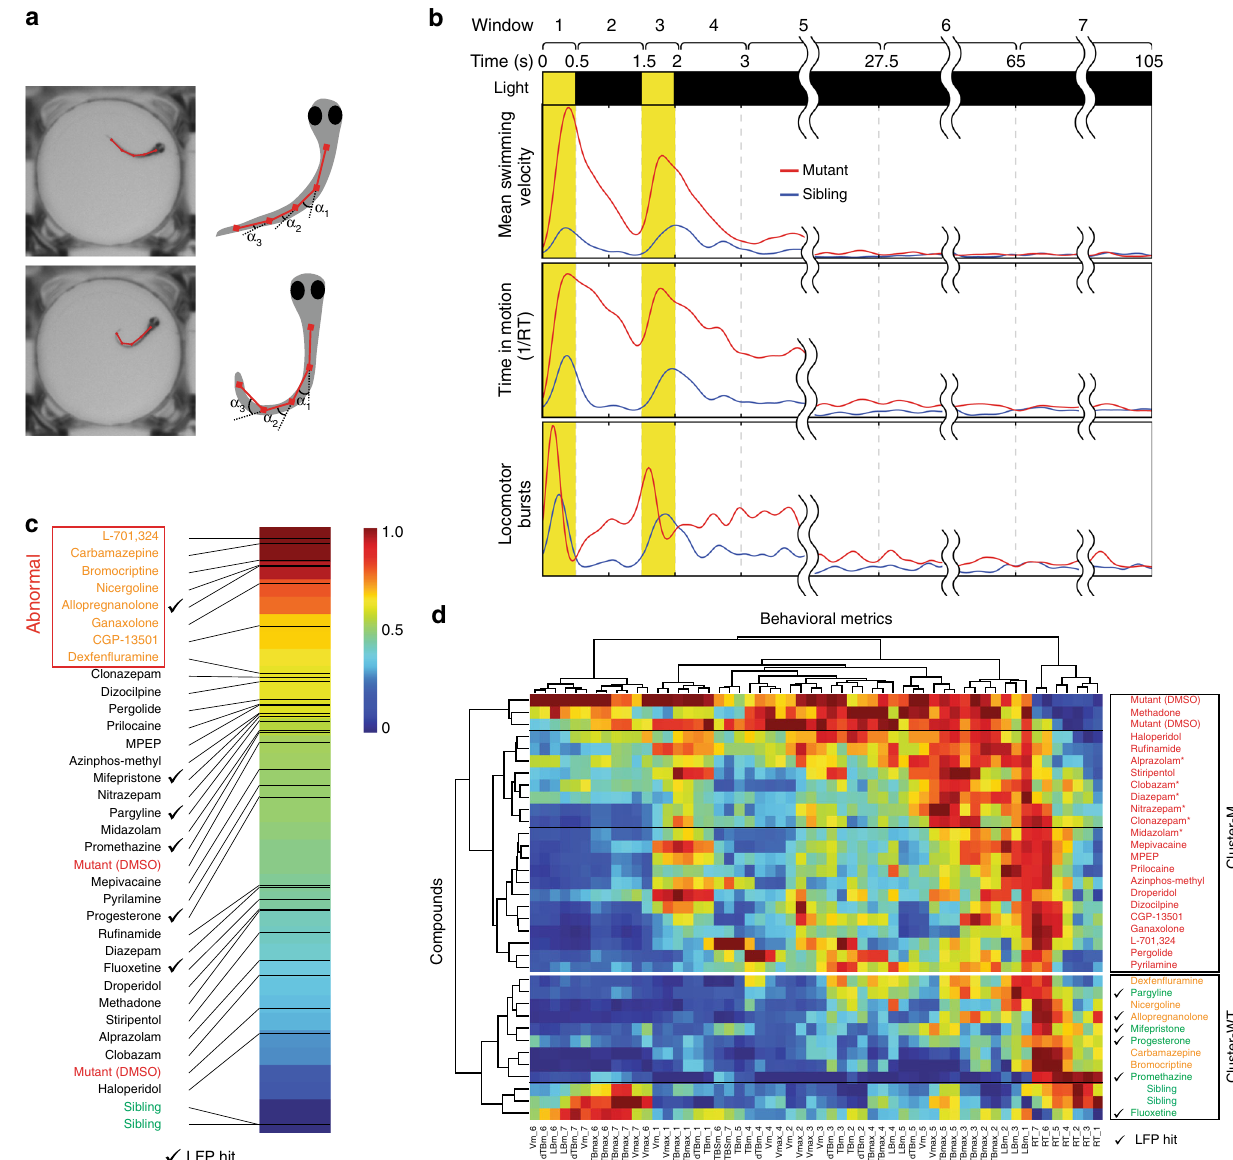
Fig. 4 Deep behavioral phenotyping. a Automated image processing algorithms are used to locate the head and multiple points along the midline axis of the tail for each larva. Behavioral metrics are calculated based on these landmarks. b Seven temporal windows are de fi ned relative to the onset of the seizure- inducing light stimulus: (1) fi rst light pulse (0 – 0.5 s), (2) inter-pulse interval (0.5 – 1.5 s), (3) second light pulse (1.5 – 2 s), (4) early post-pulse 1 (2 – 3 s), (5) early post-pulse 2 (3 – 27.5 s), (6) early interictal (27.5 – 65 s), and (7) late interictal (65 – 105 s). Eight behavioral metrics are calculated using 40+ data points ( n = 10+ larvae, each subjected to four independent light stimuli) per metric over all seven temporal intervals. Representative examples are shown for mean swimming velocity ( V m ), locomotor bursts (Burst m ), and time spent in motion (RT) in untreated (1% DMSO) scn1lab mutants (red) and sibling controls (blue). c Behavioral fi ngerprints ranked based on Euclidean distance from sibling controls (green) during interictal periods (temporal windows 6 and 7). Compounds in the upper quartile (furthest from siblings) are presumed to have adverse side-effects on resting state behavior and are designated abnormal (orange text). Mutants are indicated in red text; hits based on LFP analysis are indicated by check marks. d A 56-component behavioral fi ngerprints are generated for each compound based on all eight behavioral metrics during all seven temporal windows. Each square represents the average value for that feature. Compounds and behavioral fi ngerprints are analyzed by hierarchical clustering to identify groups that produce similar behavioral outcomes. Cluster-M contains compounds with behavioral pro fi les similar to untreated mutants (red text) and Cluster-WT contains compounds with pro fi les similar to wild-type sibling controls (green text). Compounds in Cluster-WT that cause substantial alterations in resting state behavior (temporal windows 6 and 7) are indicated in orange text. Benzodiazepines are indicated with asterisk (*), hits based on LFP analysis are indicated by check